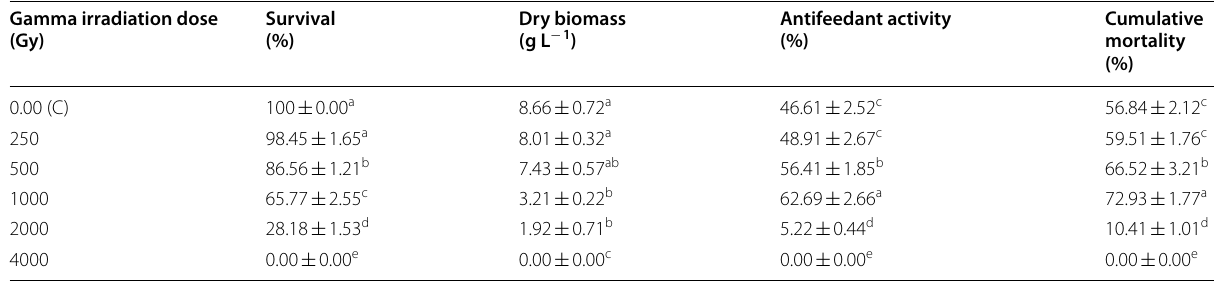
Table 2 Effect of different doses of gamma irradiation on survival (%), dry biomass (g L − 1 ), antifeedant activity (%), and cumulative mortality (%) of the 3rd instar Spodoptera littoralis larvae feeding on castor leaves treated with methylene chloride extract of A. sydowii AUMC14506